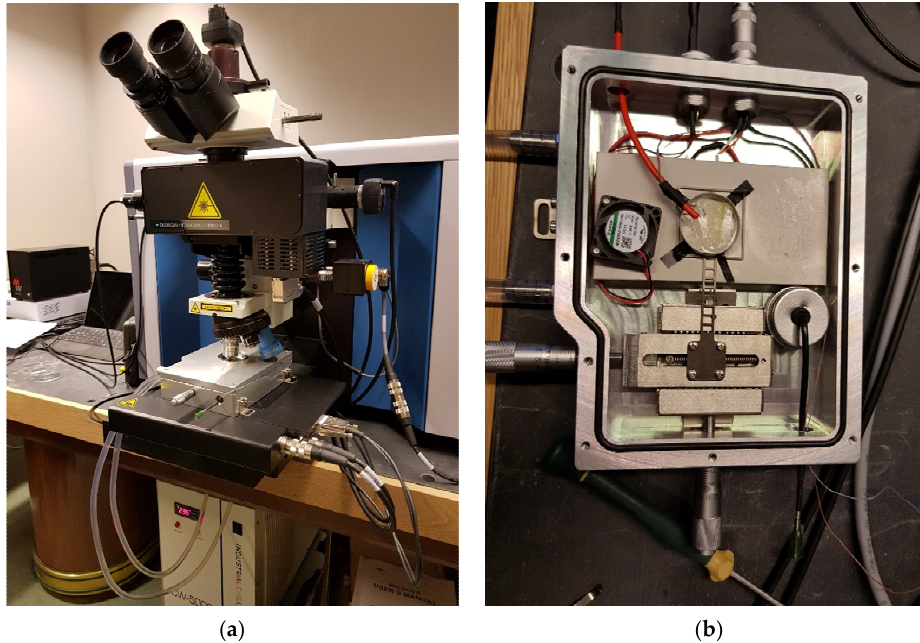
Figure 5. ( a ) Setup of Raman analysis of column samples at the University of Gothenburg using ( b ) a fluid-cooled container to maintain a temperature of − 20 °C during analysis.